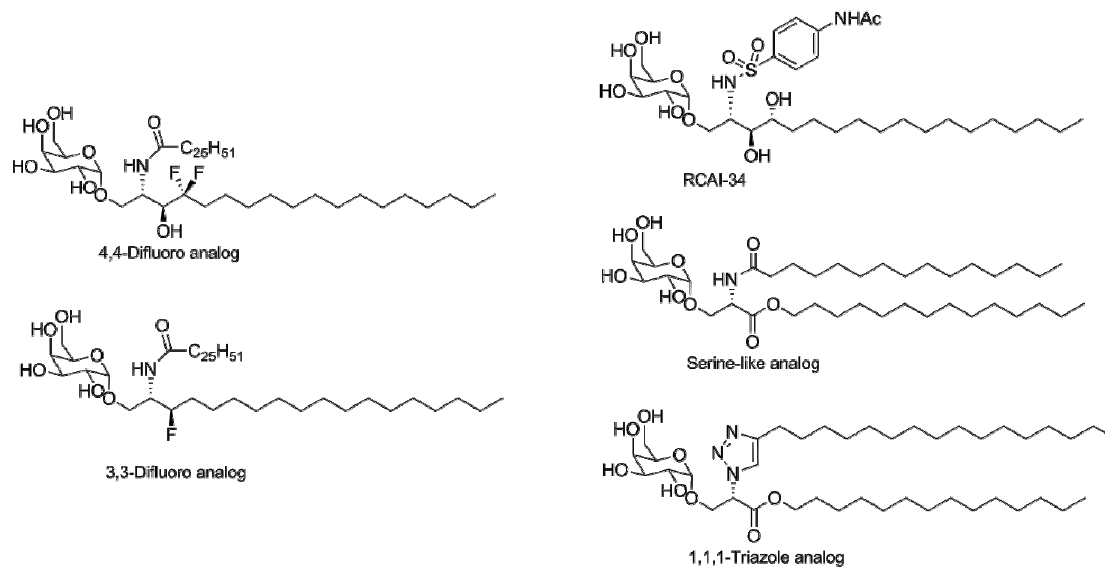
Figure 5. iNKT cell antigens with varied sphingosine